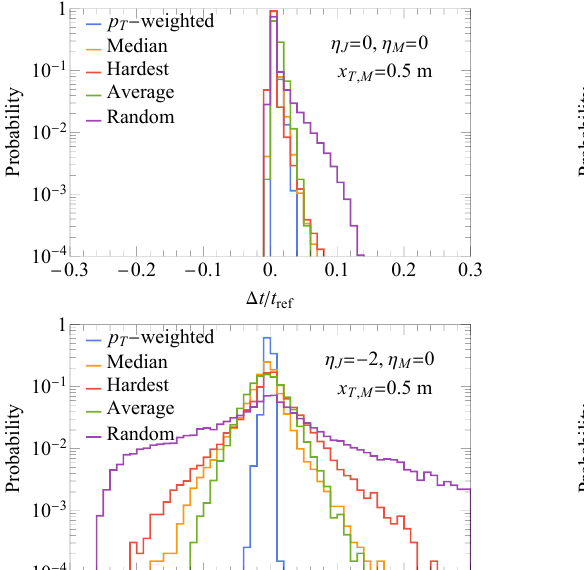
) = ( − 2 , 2) (bottom right) for J , η M